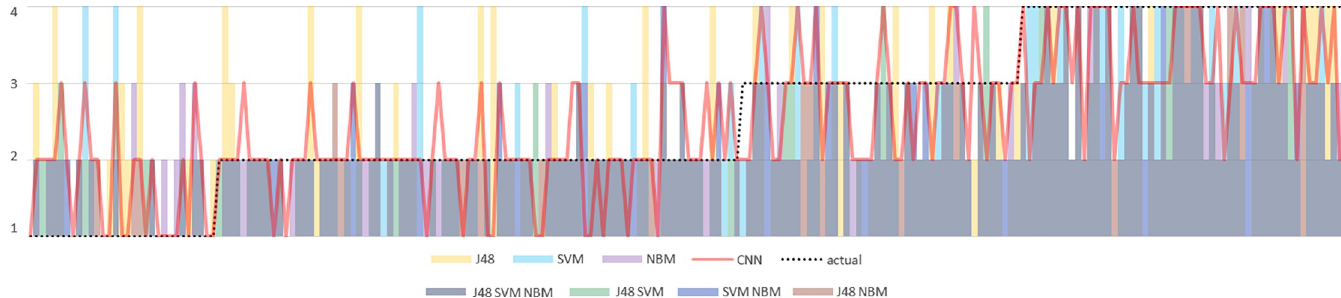
Fig 8. Bar-line combination chart of the gold scores (actual) and the predicted scores of each record on the test set. The horizontal axis is the records sorted according to their scores in an ascending order, and the vertical axis is the assigned scores ranging from 1 to 4.